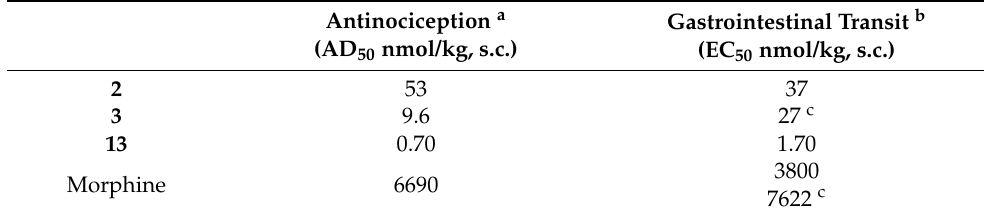
Scheme 6. Synthetic route to POMO ( 13 ). Reagents and conditions: ( a ) cinnamyl bromide, NaH, DMF, 0° C; ( b ) hydrogenation over Pd/C, glacial acetic acid, r.t., 40 psi; ( c ) 3- O -ether cleavage, refluxing 48% HBr solution. Table 5. Antinociceptive activities and gastrointestinal transit inhibition by N -methylmorphinan-6- ones 2 , 3 and 13 and